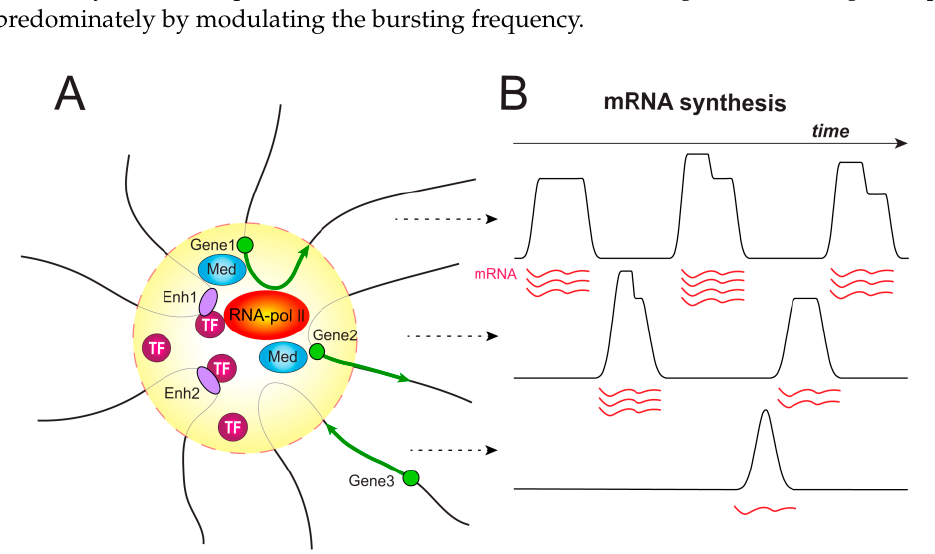
Figure 1. Transcription factory and transcriptional bursting. ( A ) Enhancers and promoters of several genes located in di ff erent chromosomal positions or even on di ff erent chromosomes cluster together in a focus within the cell nucleus during transcription [19–21]. These discrete nuclear foci, which contain the phosphorylated form of RNA polymerase II, are called transcription factories. A transcription factory represents a phase-separated droplet, where the concentration of proteins can be 100 times higher than in the surrounding nucleoplasm [22–24]. The high concentration of transcription factors in the transcription factory promotes additional rounds of transcription initiation, facilitating the interaction between regulatory elements. Three potentially co-expressed genes share one transcription factory. Chromatin fibers are decondensed (thin gray line) inside the factory and condensed outside (thick black line). TF, transcription factor; Med, the Mediator complex; Enh, enhancer; yellow circle, transcription factory. ( B ) A hypothetical vision of the organization of bursting in space in eukaryotes is represented. Gene1 is expressed and located within a transcription factory at a given time point. Gene2 has already been expressed and leaves the transcription factory now. Gene3 now returns to the factory. In accordance with the model described in [25], the factory includes only one polymerase molecule, thus producing non-overlapping peaks of mRNA. The regulation of transcription in one factory can be carried out by multiple enhancers (only two enhancers are shown).